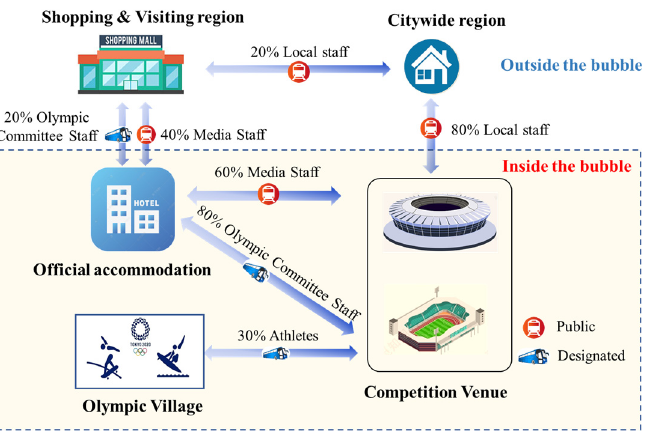
Figure 1. The routes and activities of different groups of people during the simulation period.